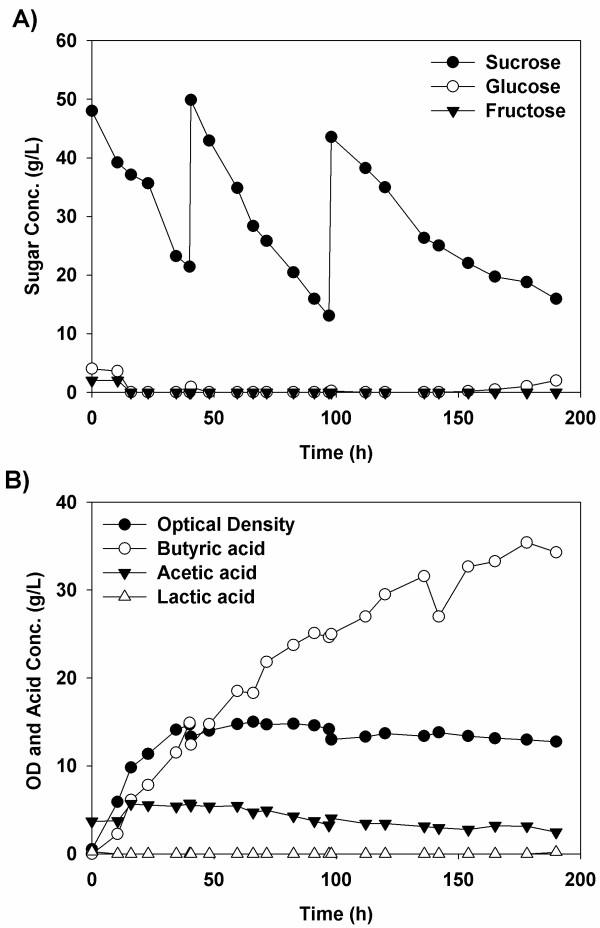
Typical B. sp. SGP1 and C. tyrobutyricum ATCC 25755T co-culture fed-batch fermentation in RCM supplemented with sucrose at pH 5.5 and 37°C. The plots show (A) the sugars consumption profile and (B)the optical density of the cultures and their production profiles for butyric, acetic and lactic acids.